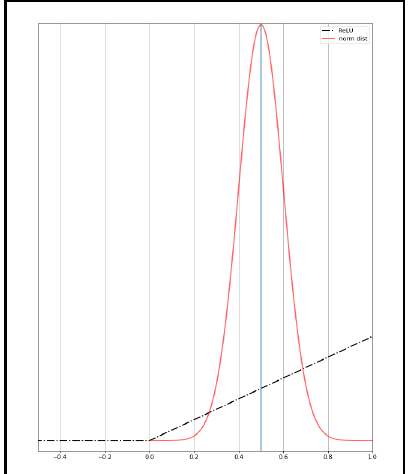
Figure 3: Sample set of image prediction on a validation image set This method utilizes the properties of the modified ReLU activation function and the resulting distribution of confidence levels to forward those images with the lowest confidence for extra analysis. Such a method reduces the need for a human analyst input to better make use of their time.